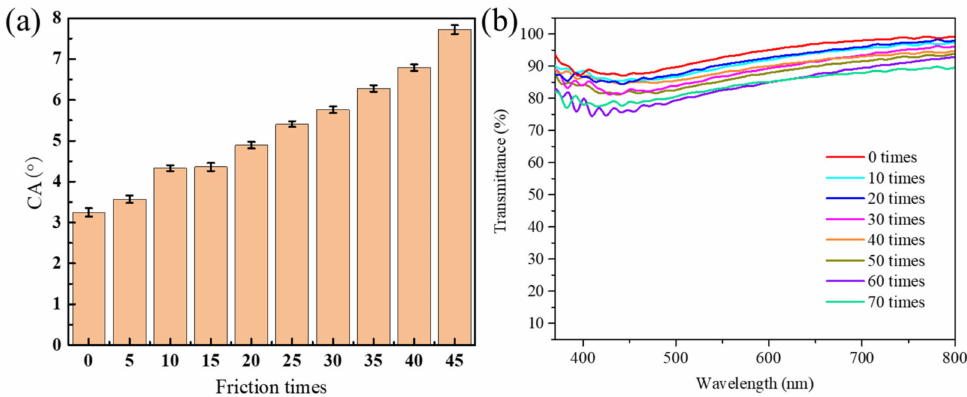
Figure 11. ( a ) Relationship between CA and friction times of C-P film surface; ( b ) Relationship between transmittance and friction times of C-P film surface.